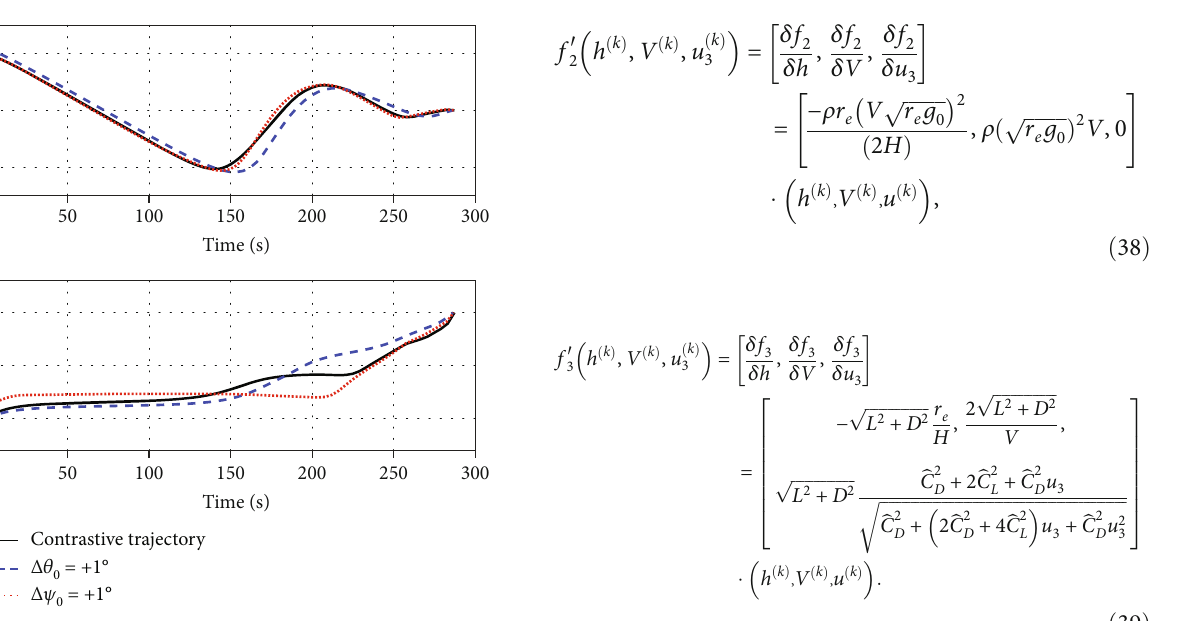
ffiffiffiffiffiffiffiffiffiffiffiffiffiffiffi